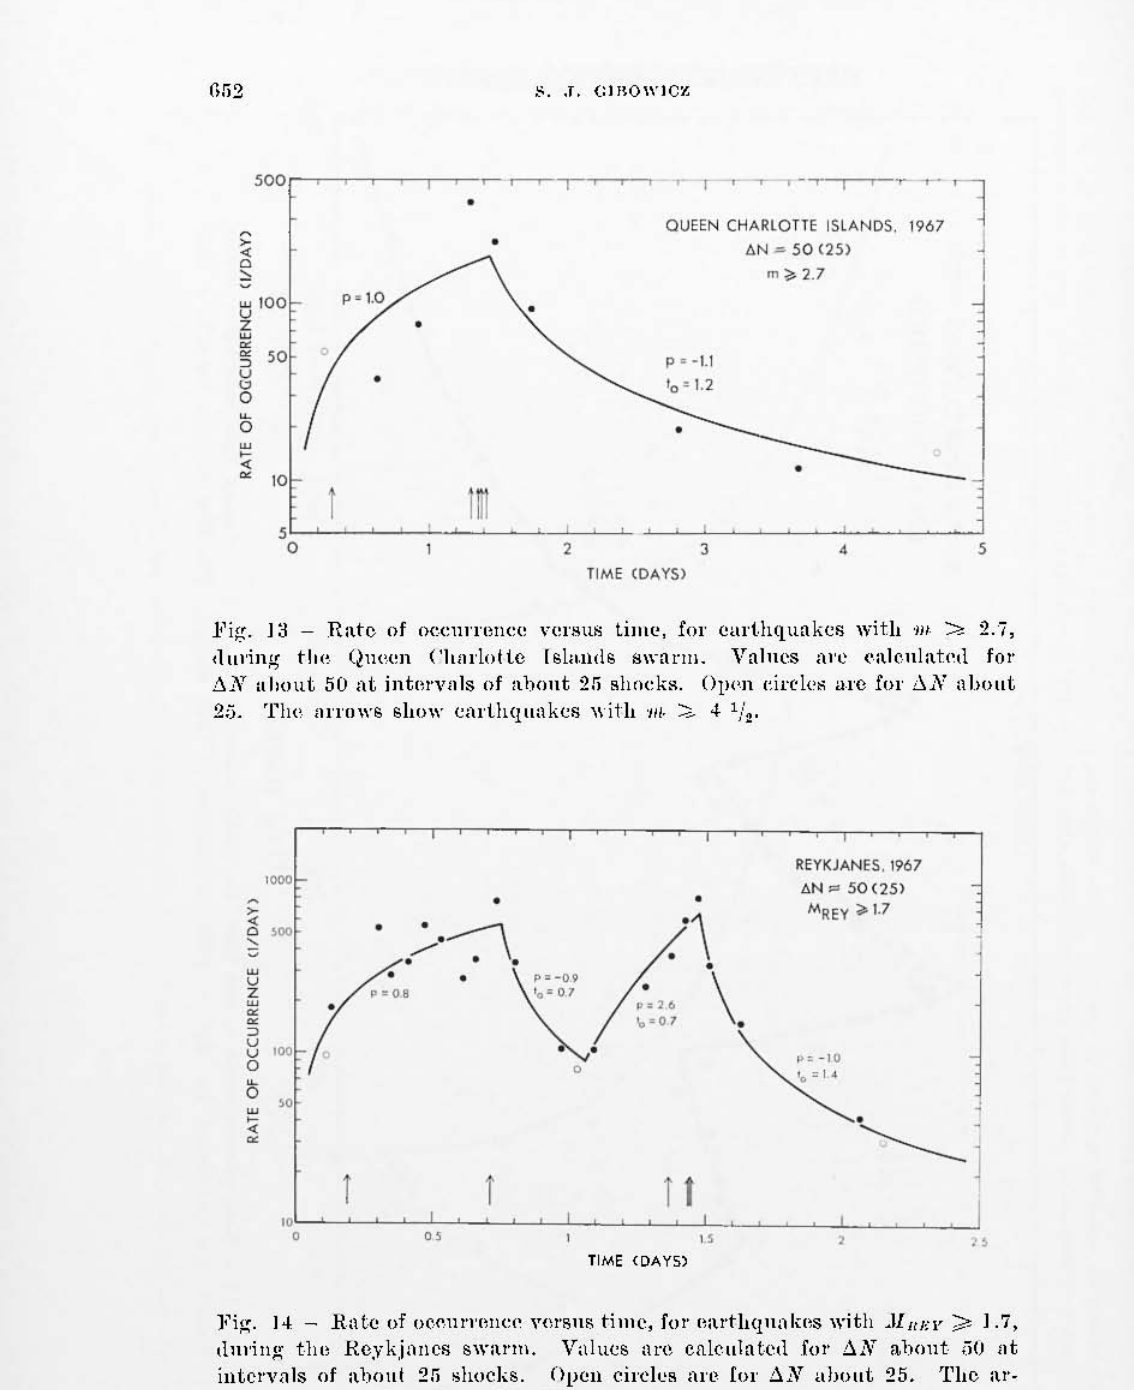
Open eirdes an, [or !1.N ahollt 25. The ar